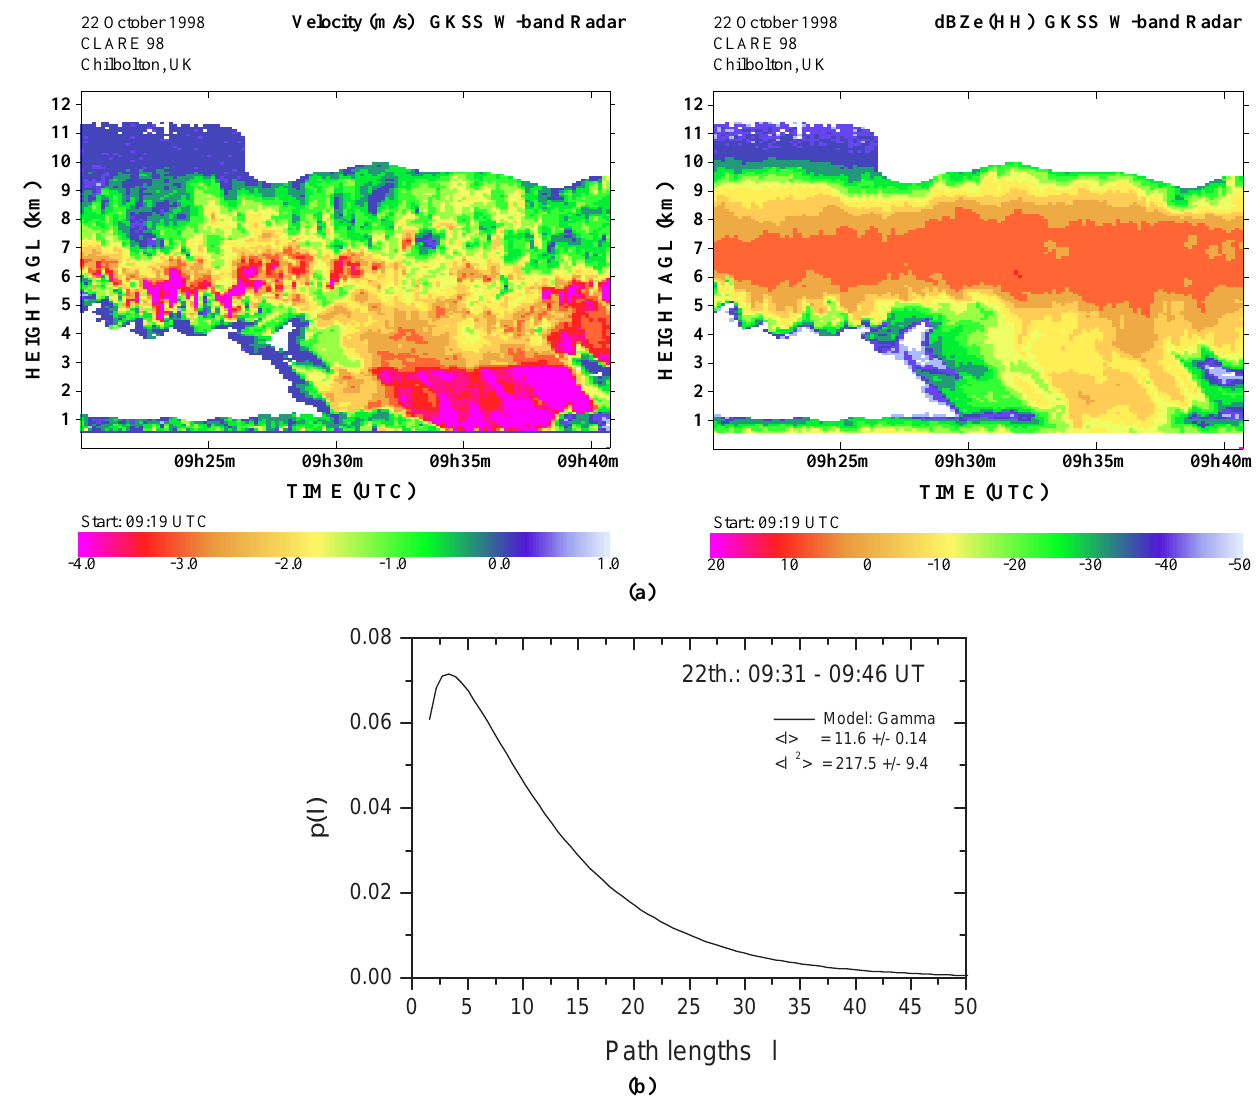
Fig. 5. (a), (c) Cloud structure (backscatter ratio) and vertical (Doppler) velocity measured by the 94GHz cloud Radar MIRACLE. In the first Case (a) two pronounced layers can be found, while no clear layer borders are present in the second Case (c). In this case the cloud fills the sky between 300m and 10km and is internally more inhomogeneous. (b), (d) The retrieved PPD for the two cases reflect the difference in cloud structure. The distribution is broader for the first Case (b), as expected for two cloud layers, see Fig. 6 (Fig. 5 continues next